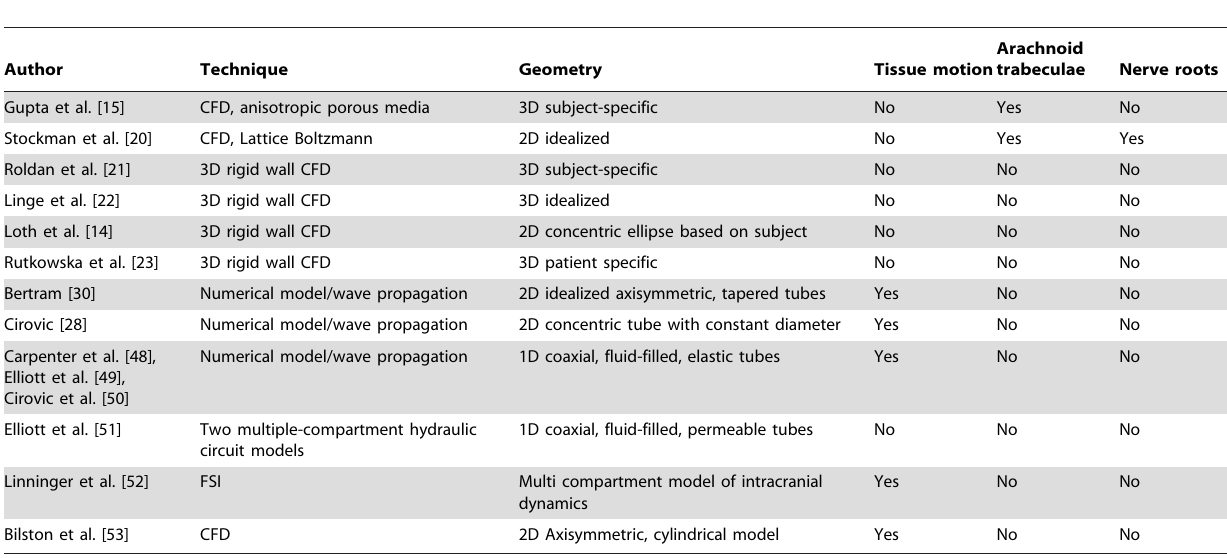
Table 1. Literature review of computational simulations of CSF motion in the cervical SSS and/or craniospinal junction in healthy conditions and patients with craniospinal disorders.